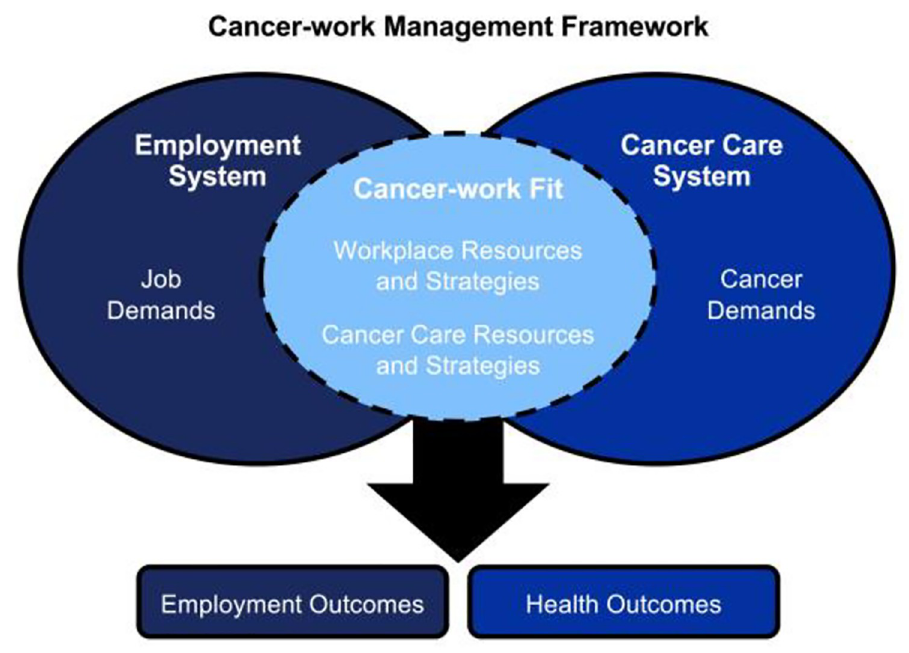
Fig 1. Cancer-work management framework. Source: Swanberg, Vanderpool, & Tracy (2020).